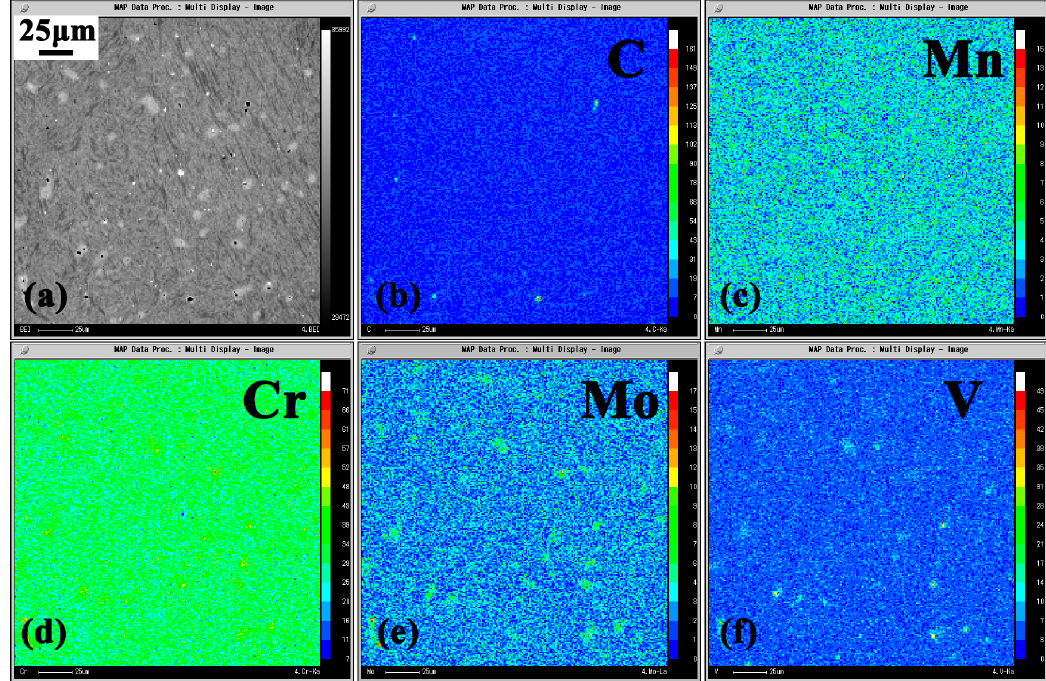
Figure 7. Characterization of “island-like” structures when deformed at 1340 °C. ( a ) Back scatter mode, ( b – f ) are C, Mn, Cr, Mo, and V elemental distributions, respectively.